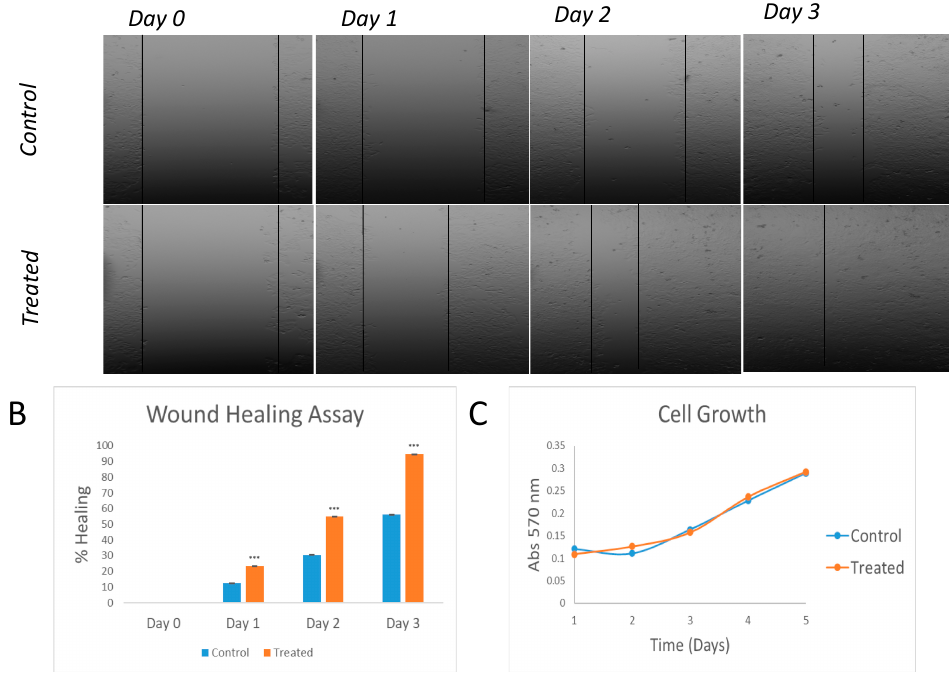
Figure 3. Wound-healing and proliferation assays in TNF α -treated in HeLa cells. Images of wound- healing assay performed on HeLa cells. Treated vs control ( A ) and graph representation ( n = 3; *** p < 0.001 vs control) ( B ). Study of cell growth differences between treated and untreated cells ( C ).